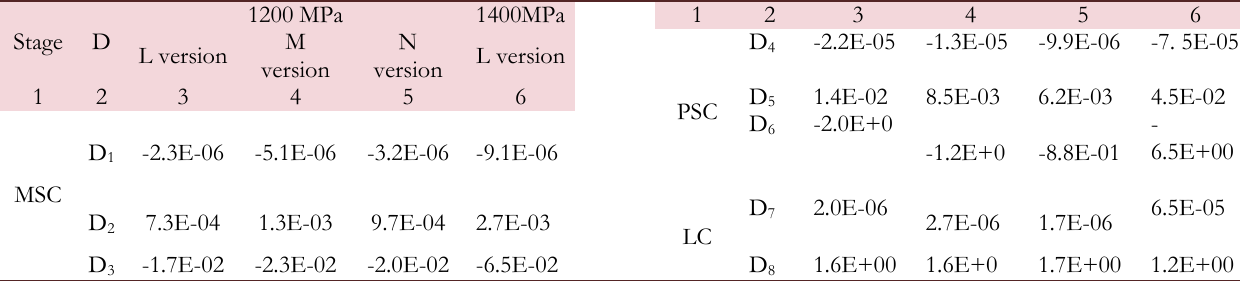
Table 1: Values of coefficients D in Eq. 1 at Δσ = 1200 & 1400 MPa, Steel A.